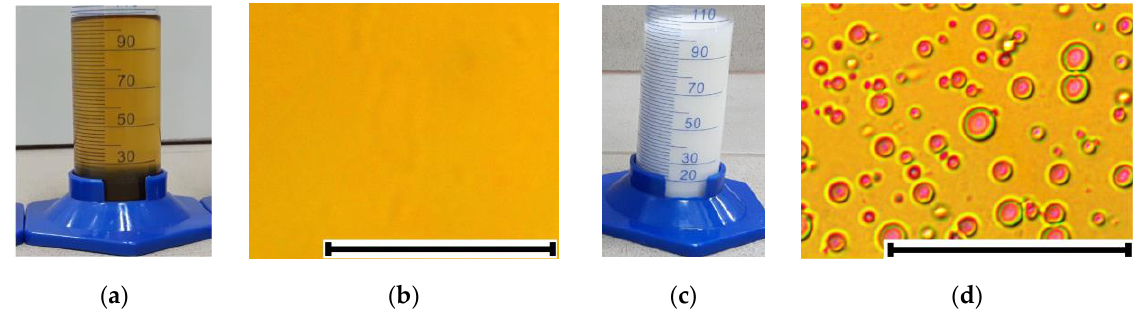
Figure 2. Fuel mixture ingredients; ( a ) emulsifier, ( b ) microscopic photo S2; ( c ) fuel-water emulsion; ( d ) microscopic photograph of a fuel-water emulsion. Scale bar corresponds to 50 µm.